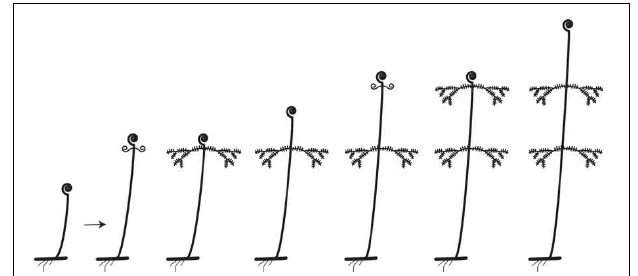
FIGURE 8 | Rhythmic leaf extension growth in the Gleicheniaceae (from Moran, 2004).